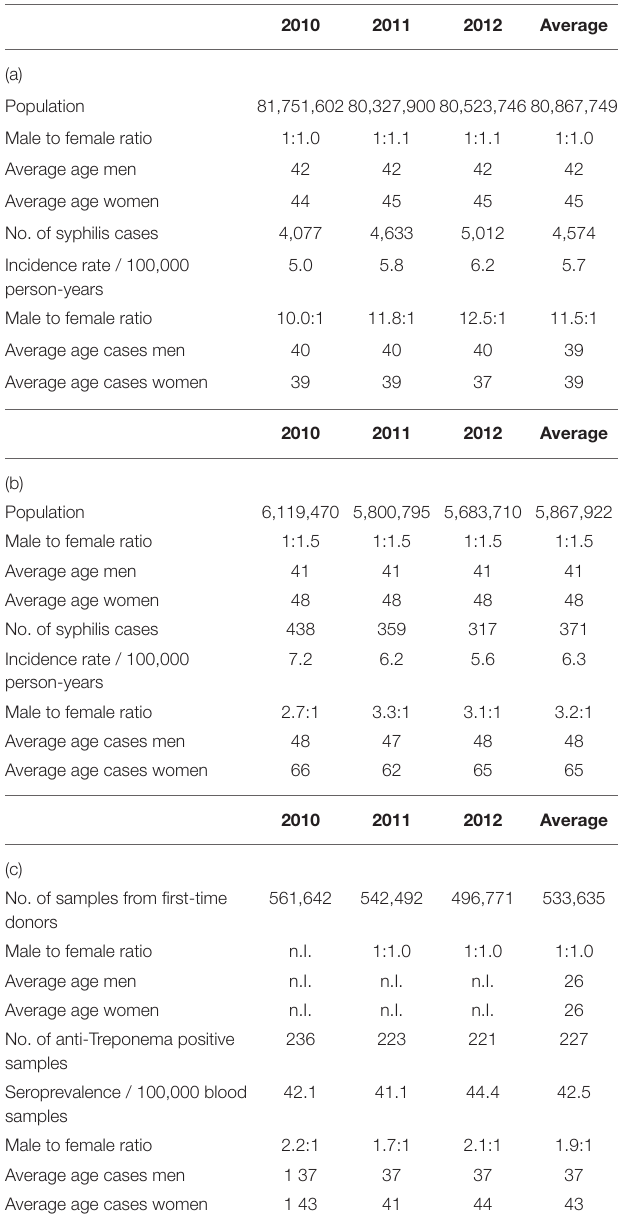
(30 %), while 3 % of the incident diagnoses were coded congenital